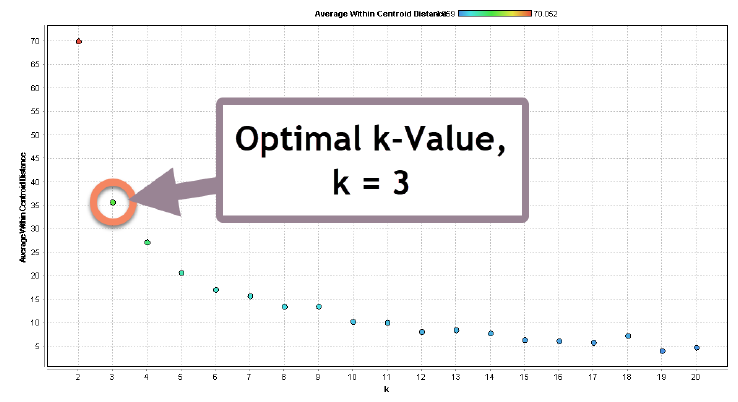
Fig. 5. The appropriate number of clusters of course 7000103 (2020) Table 3. Average within centroid distance (ACD) results for course 7000103 (2020) 𝒌 -value